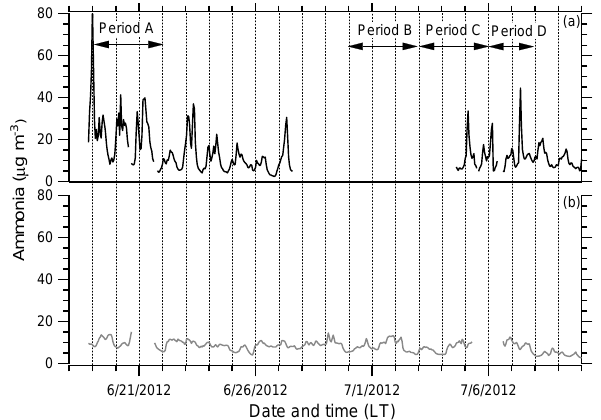
Figure 13. Time series of hourly averaged ammonia observed at (a) SPC and (b) Bologna. The dashed lines indicate midnight local time (UTC + 2). Periods A, B, C, and D are also